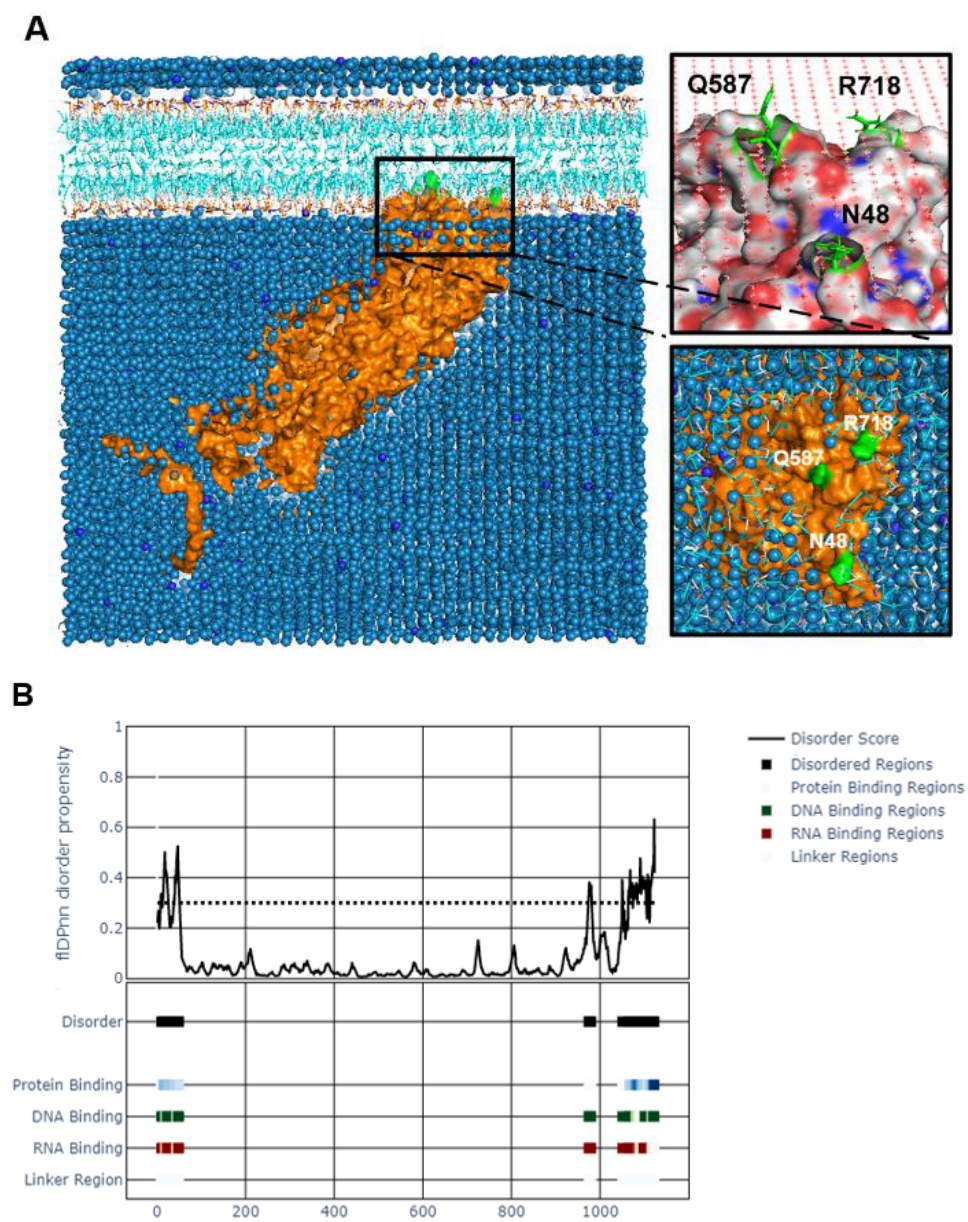
Figure 5. Interaction analysis of tegument protein UL37. ( A ). Molecular dynamics simulation of HSV-1 UL37 bilipid membrane interaction using MemProtMD. HSV-1 UL37 is predicted to be a peripheral protein interacting with the inner layer of the bilipid membrane. ( B ). Potential DNA, RNA and protein binding regions within disordered N-and C-termini. Binding sites were identified within the disordered regions using flDPnn.